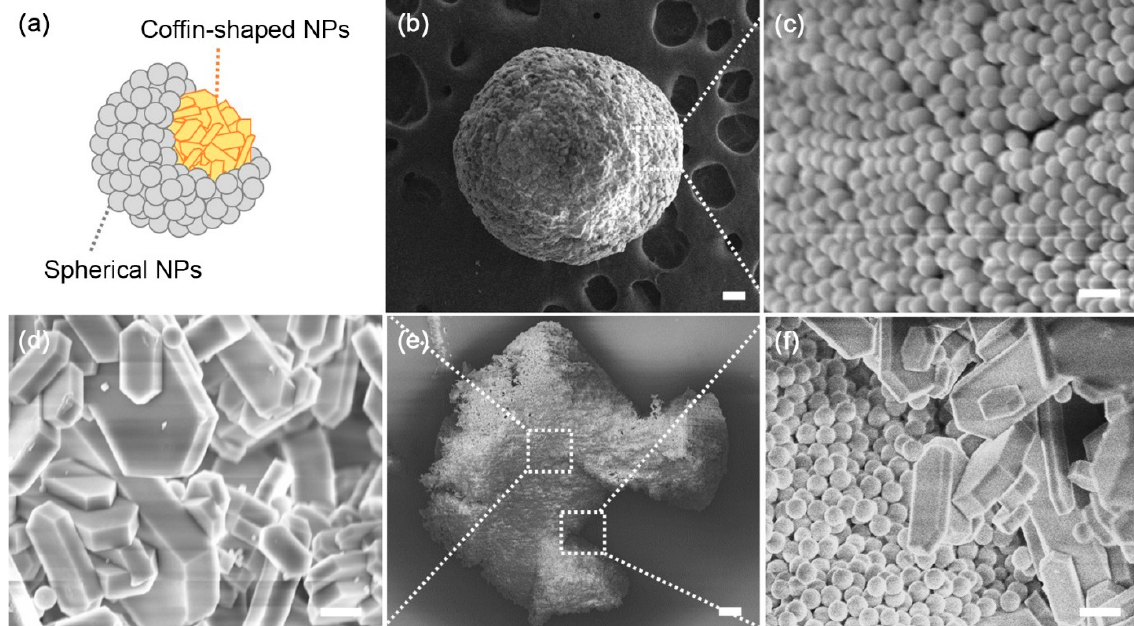
Figure 7. Core/shell supraparticle by size effect. ( a ) A schematic of core/shell supraparticle with coffin-shaped NPs/spherical NPs. ( b , c ) SEM images of the surface of the core-shell supraparticle. ( e ) Cross-sectional SEM image of the core-shell supraparticle, characterized after breaking the supraparticle. ( d , f ) High magnification SEM images of the inner-structure (indicated as boxes in image ( e )) of the supraparticle; ( e ) the core of core and shell and ( f ) the boundary, respectively. The scales are 100 μ m for ( b , e ) and 1 μ m for ( c , d , f ).